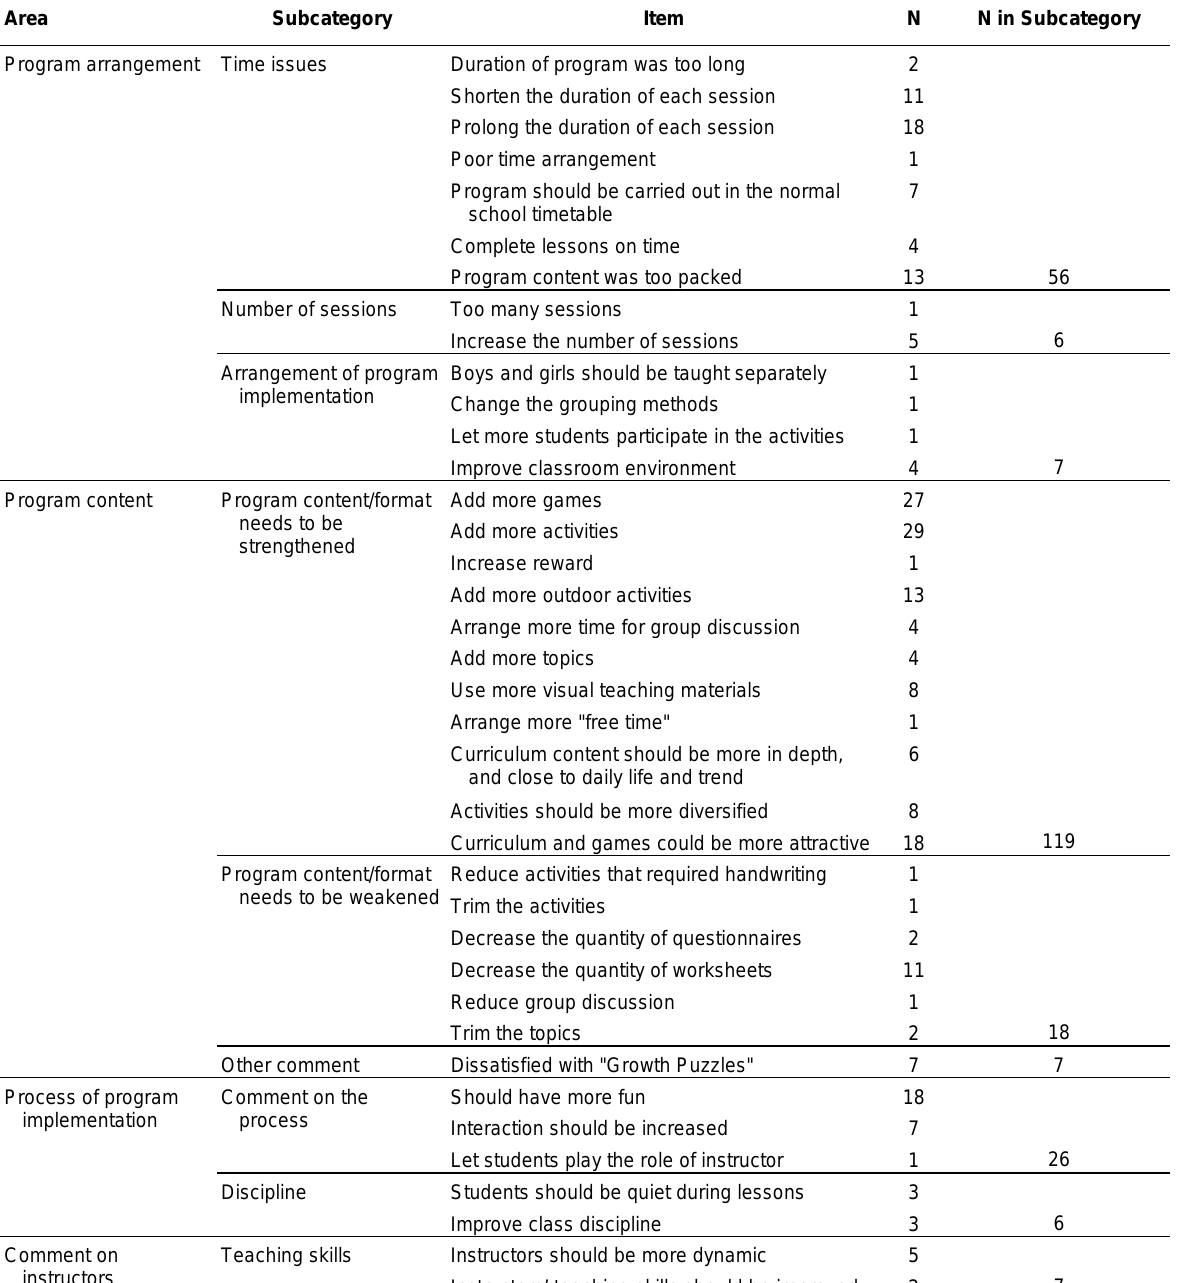
Summary of the Students' Comments on the Question “Which Aspects of the Program should be